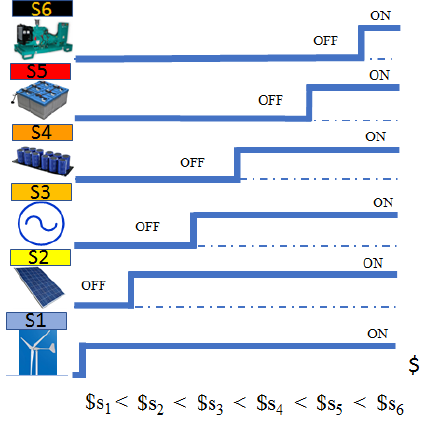
Figure 4. Operating load